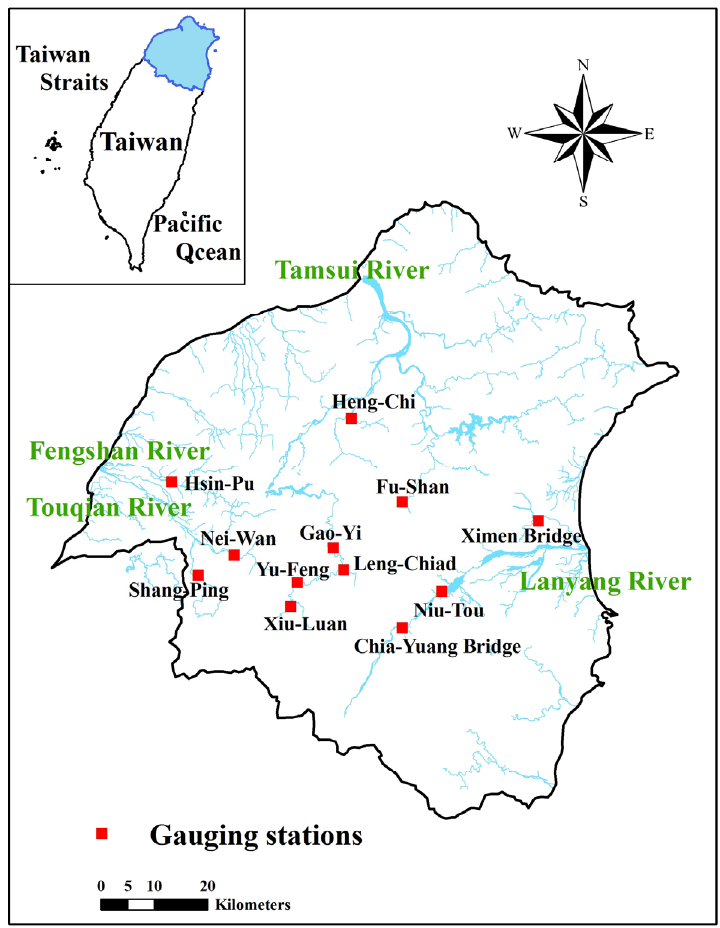
Figure 1. Locations of study area and streamflow